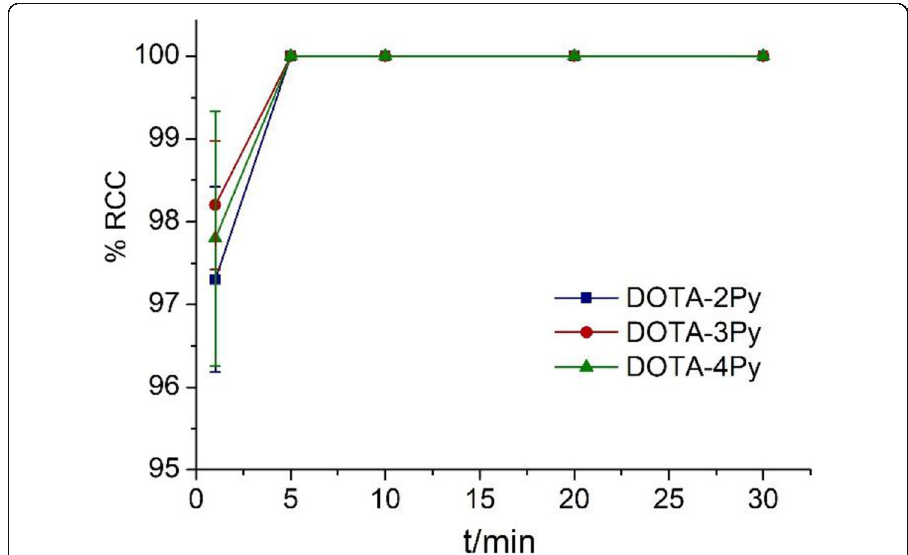
Fig. 4 64 Cu labeling conversion of DOTA-2Py, DOTA-3Py and cyclen-4Py at 1, 5, 10, 20 and 30 min performed with ligand concentration of 1 × 10 − 4 M (10 nmol ligand, 3 MBq 64 Cu) and ambient temperature ( n =